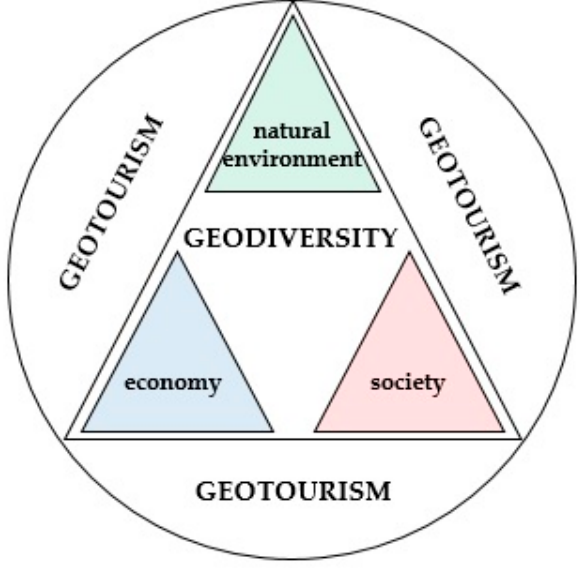
Figure 1. Sustainable development of geodiversity in geotourism.